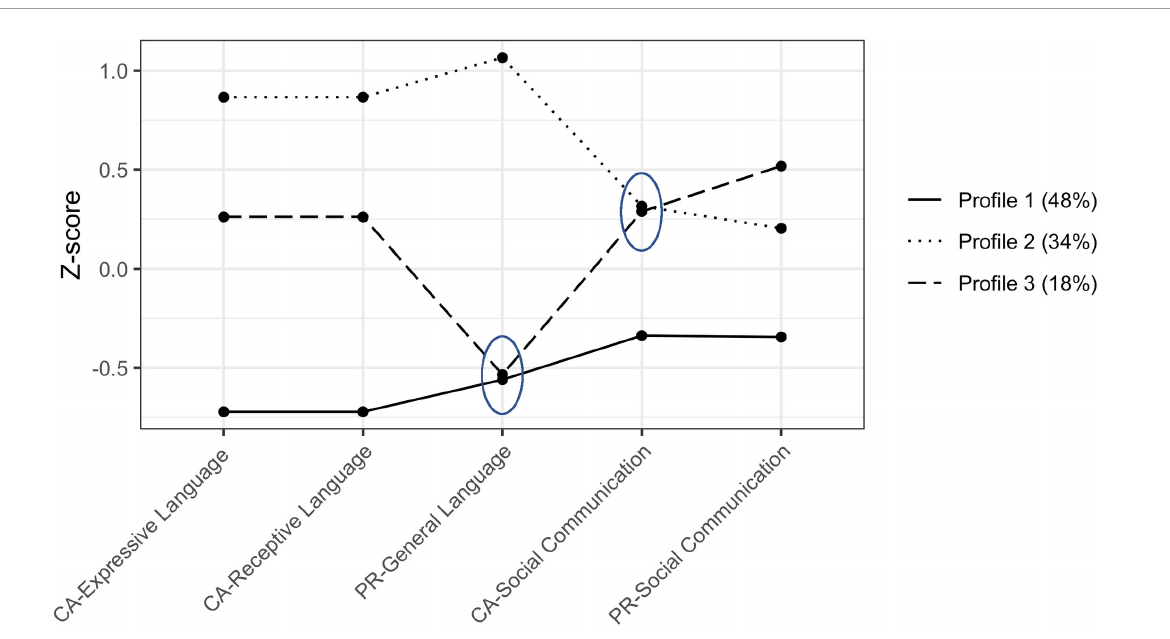
FIGURE1 Language and social communication variable z-scored means for the three-profile solution. Ellipses encompass means that are not significantly different. CA, clinician-administered; PR, parent-rated. Profile 1, “Relatively Low Language and Social Communication Abilities;” Profile 2, “Relatively Elevated Language and Social Communication Abilities;” Profile 3, “Informant Discrepant Language and Relatively Elevated Social Communication Abilities.”